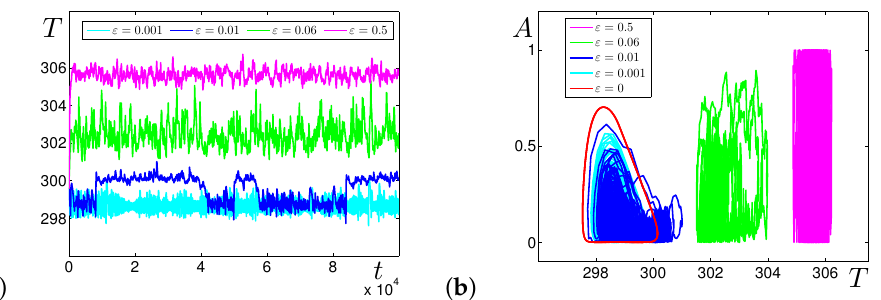
Figure 3. Stochastic system (2), (3) for γ = 0.02, σ 1 = 0, σ 2 = 1: ( a ) time series, ( b ) phase trajectories.